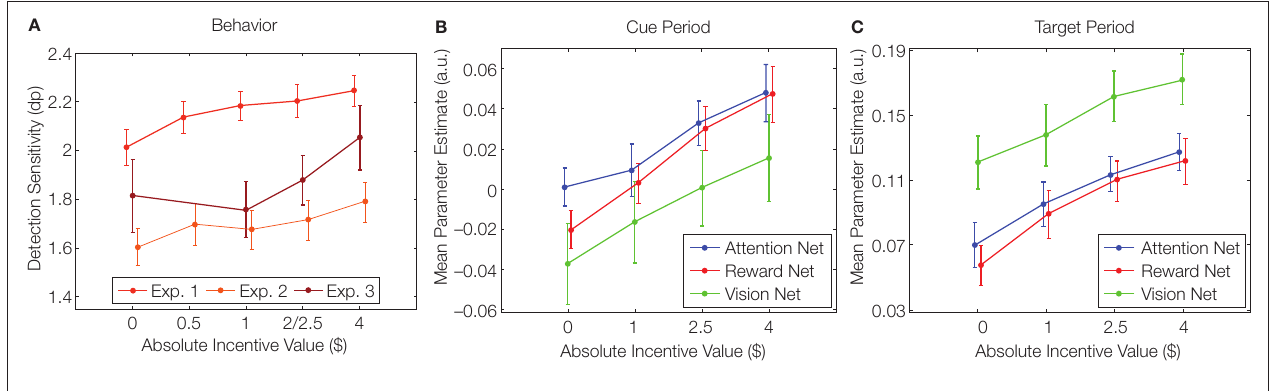
Figure  | Behavioral and neural effects of incentive motivation. (A) In all experiments, the detection sensitivity measure dprime (dp) increased as a function of absolute incentive magnitude. Red line: experiment 1 of Engelmann and Pessoa (2007); light orange line: experiment 2 of Engelmann and Pessoa (2007); dark red line: behavioral results of Engelmann et al. (2009).